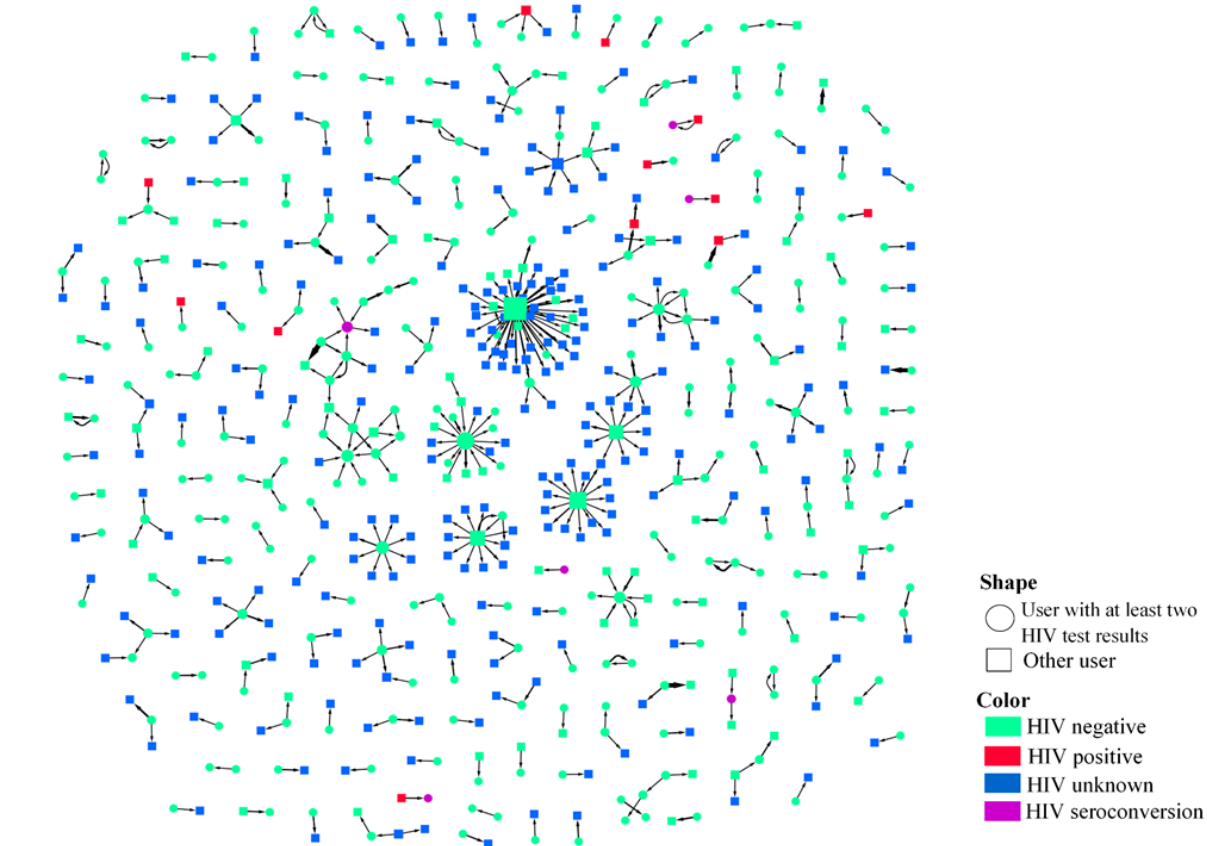
Figure 5. Networks formed by the app’s partner notification